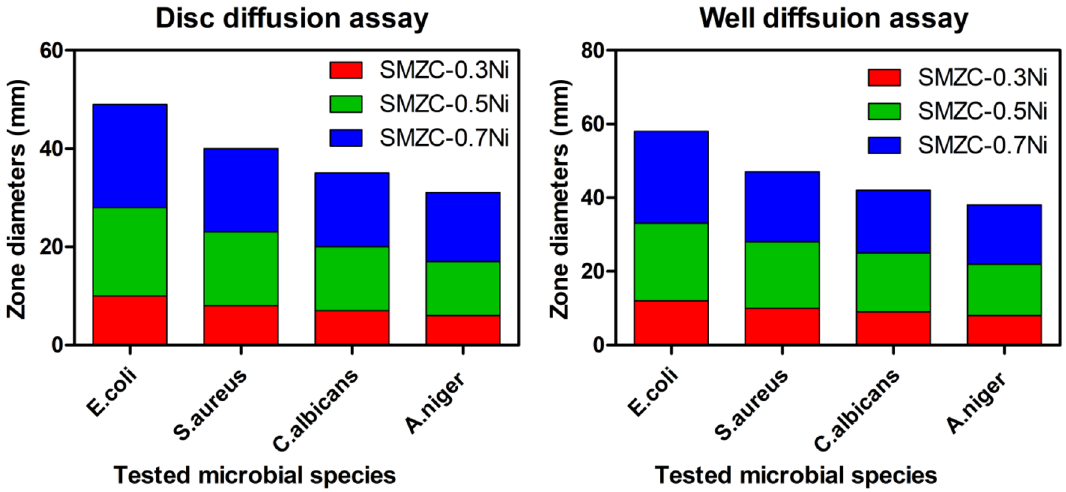
Figure 8. Measured CZD formed from investigated nanocomposites around targeted microbial